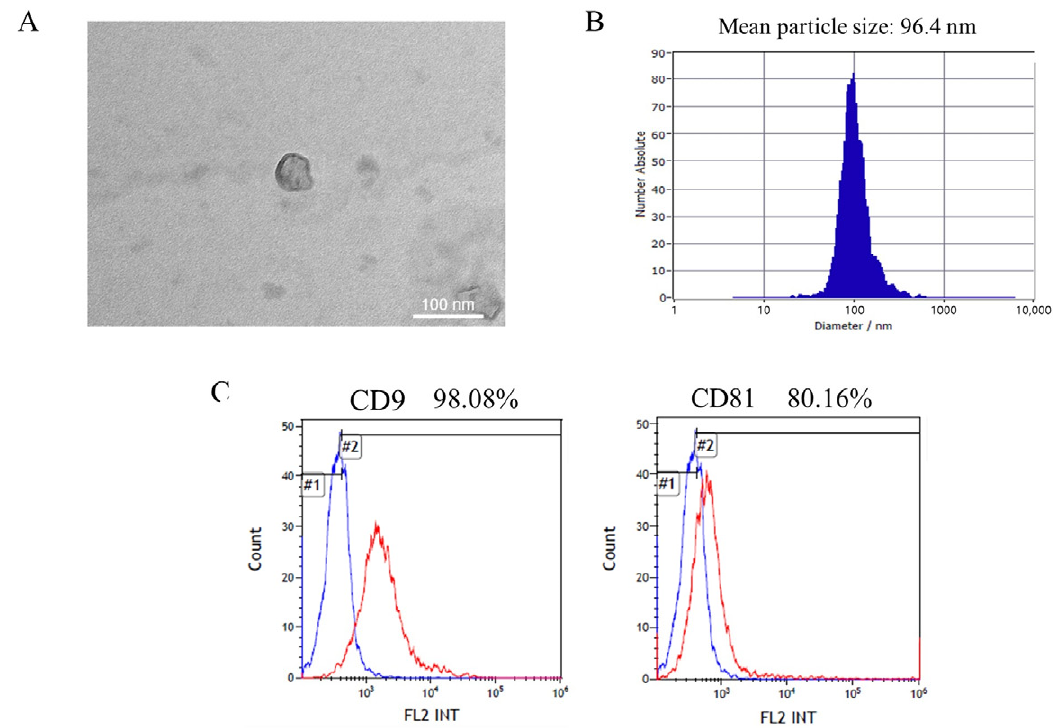
Figure 5. Isolation and characterization of exosomes obtained from serum. ( A ) Transmission electron microscopy showing exosome morphology and size. Scale bar = 100 nm. ( B ) Nanoparticle tracking analysis of exosomes in the mouse serum to confirm the size distribution. ( C ) Flow cytometry data confirming the detection of exosome markers (CD9, CD81) (#1; Negative control, #2; CD9,